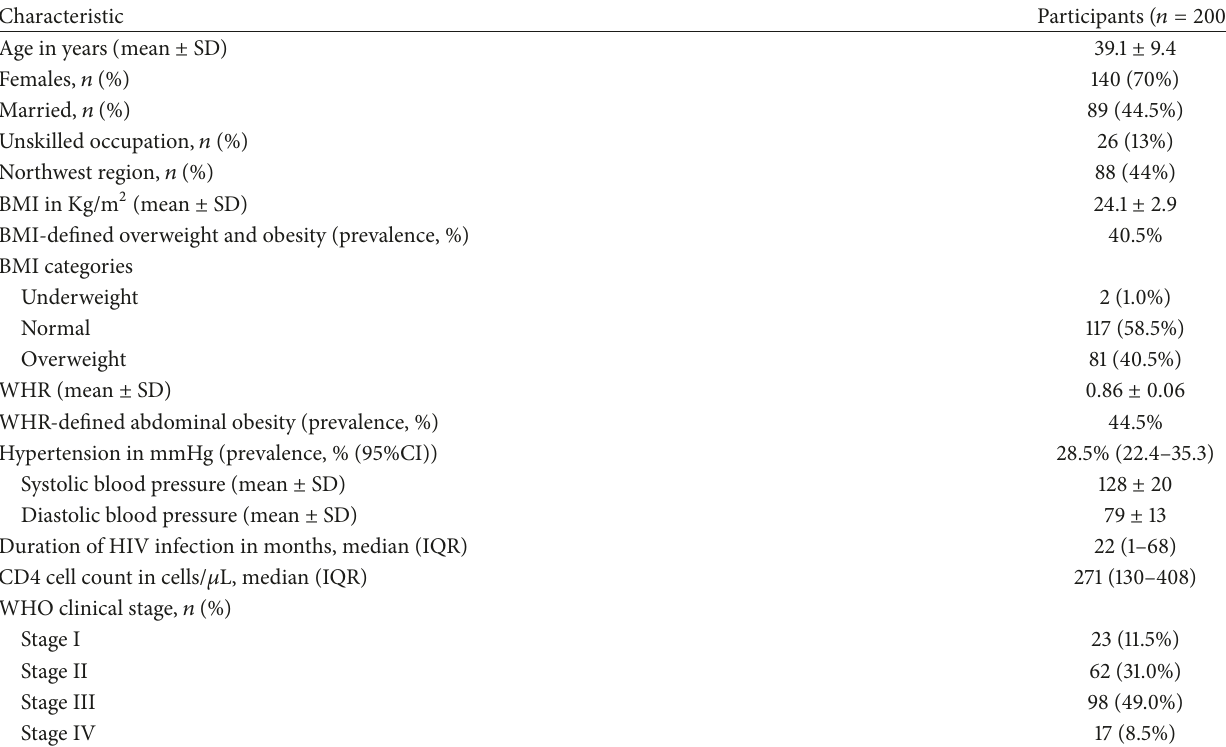
Table 1: Sociodemographic and clinical characteristics of the